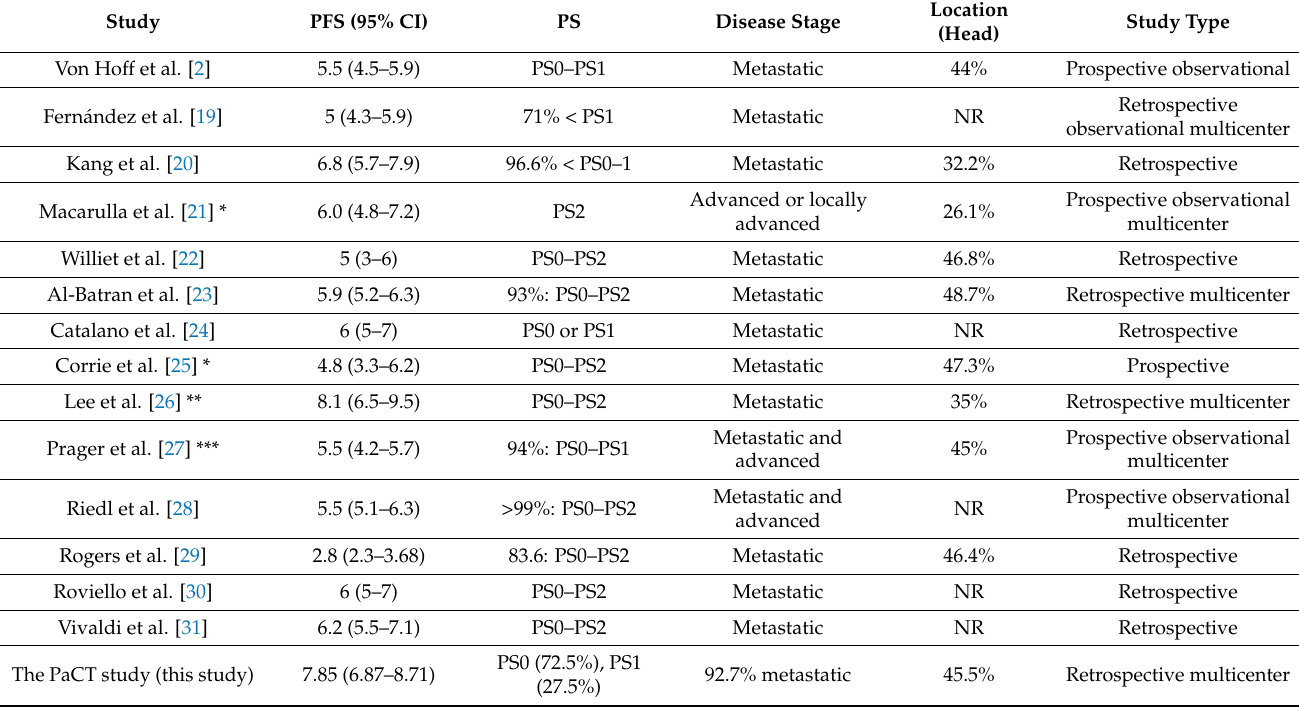
Table 2. Clinical characteristics of the 14 studied involved in the reference PFS estimation and the PaCT study. *: For these studies the combined population of two arms (both treated with N–G) was used, PFS was calculated as the weighted average of the two arms. **: For this study the part of the population that continued treatment was used. ***: 95% CI was not reported in this study, the reported CI was estimated by using information from the other studies. PS, performance